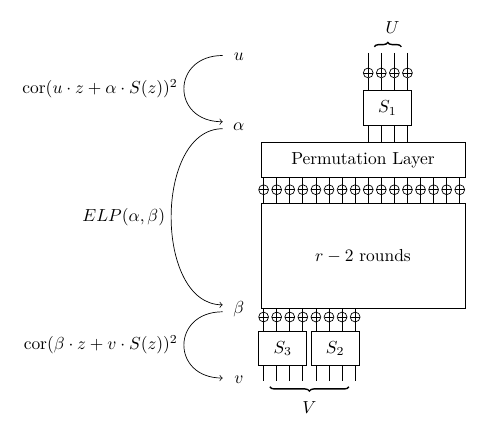
Figure 3: Estimating the capacity of a multidimensional linear